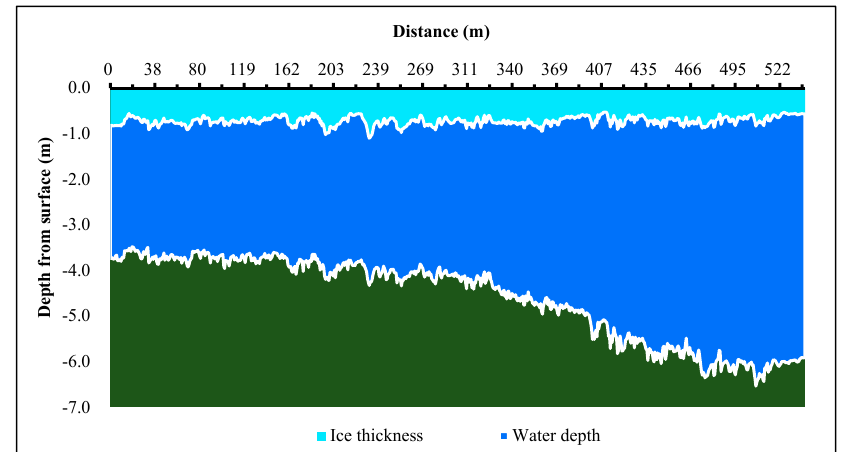
Figure 2. Ice cover thickness and water depth as measured along the Longdao Wharf section of the Mohe reach, Heilong River.